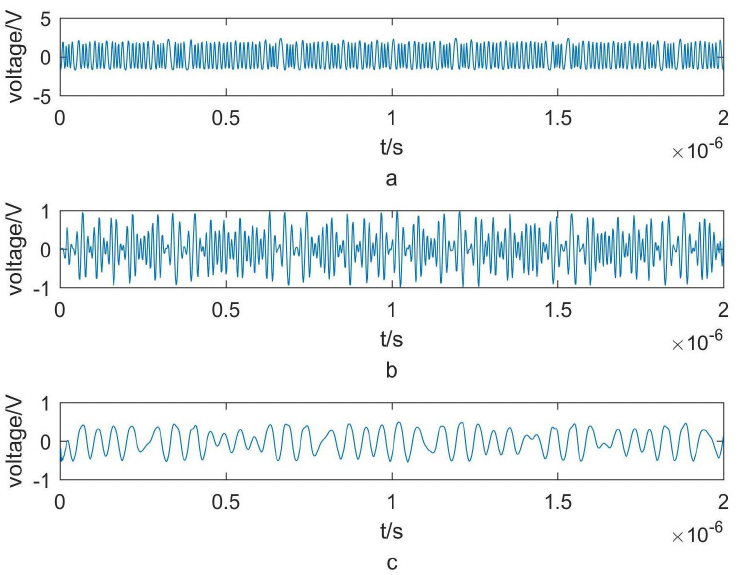
Figure 7. Signal demodulation process: ( a ) collected balance detector signal, ( b ) differential signal, ( c ) envelope detection signal.